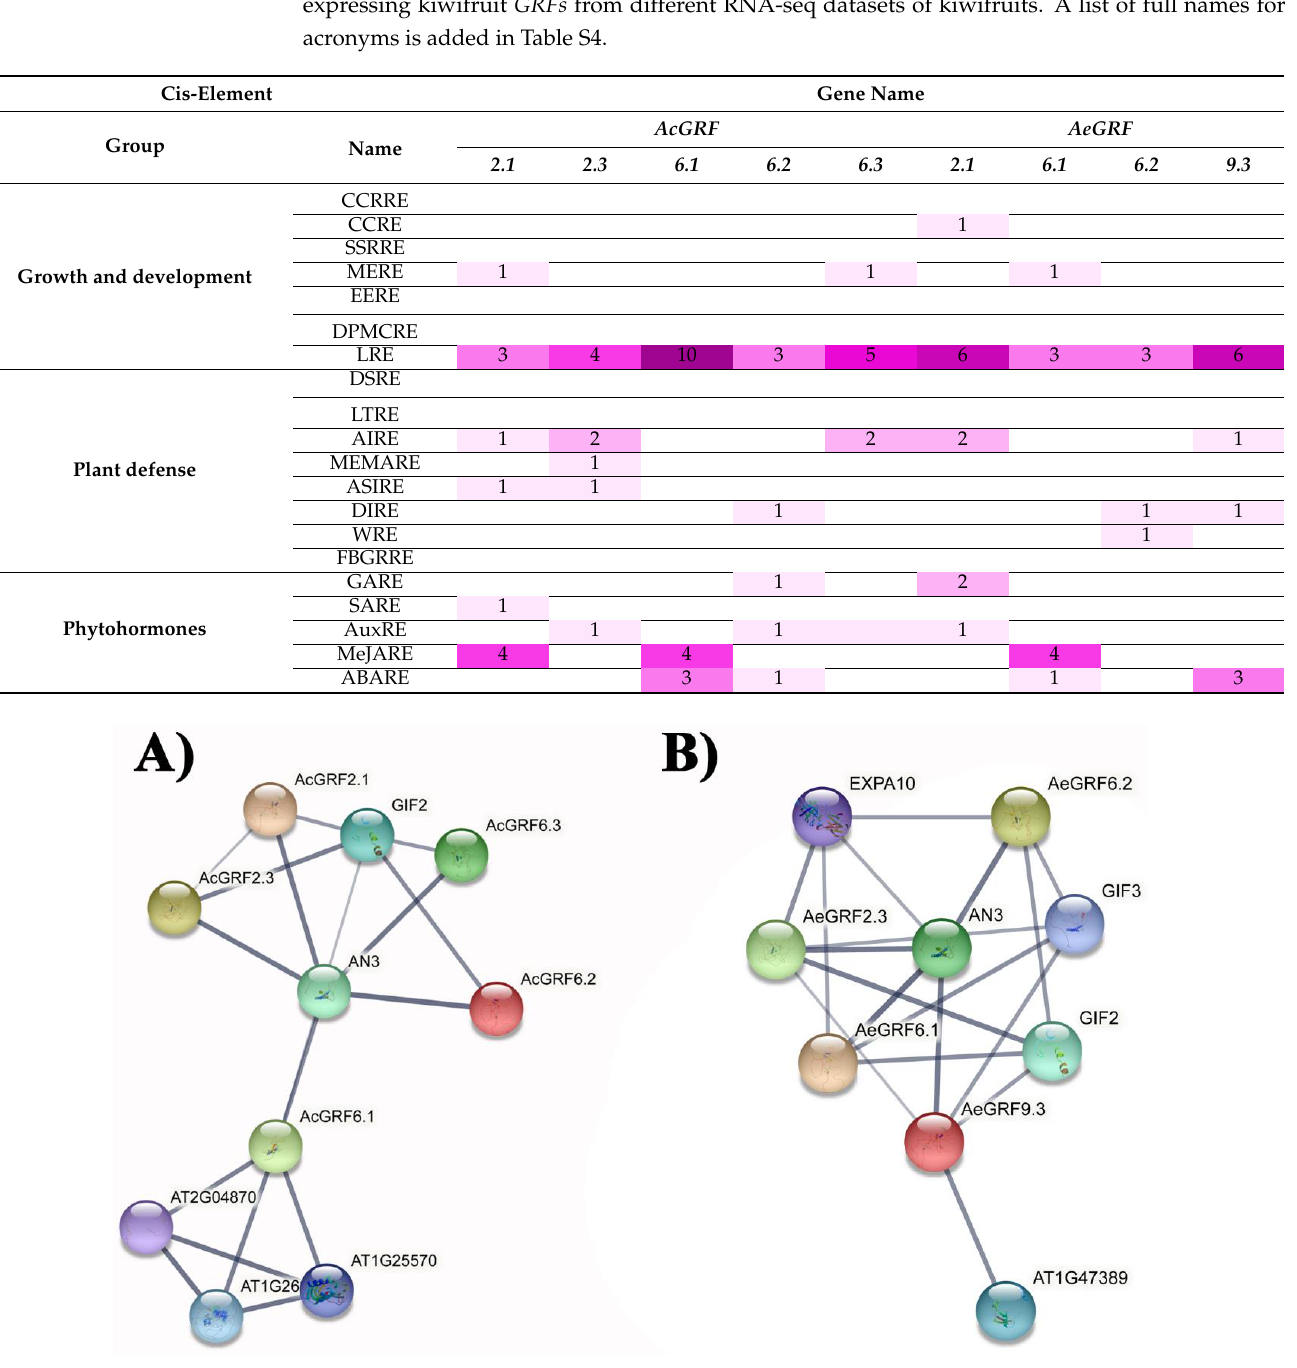
Figure 6. Prediction of protein-protein interaction networks for kiwifruit GRFs based on A. thaliana orthologs. ( A ) Protein-protein interaction networks for AcGRF proteins. ( B ) Protein-protein interaction networks for AcGRF proteins. Grey line thickness indicates the strength of protein-protein in- teraction.